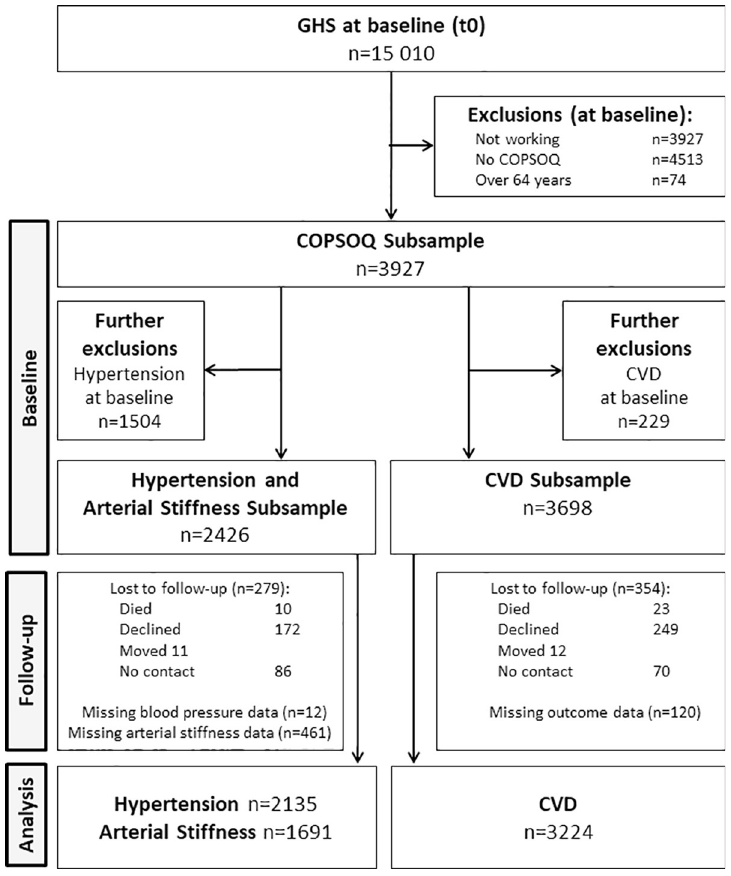
Fig 1. Study flow chart describing the selection of the hypertension/arterial stiffness and the CVD